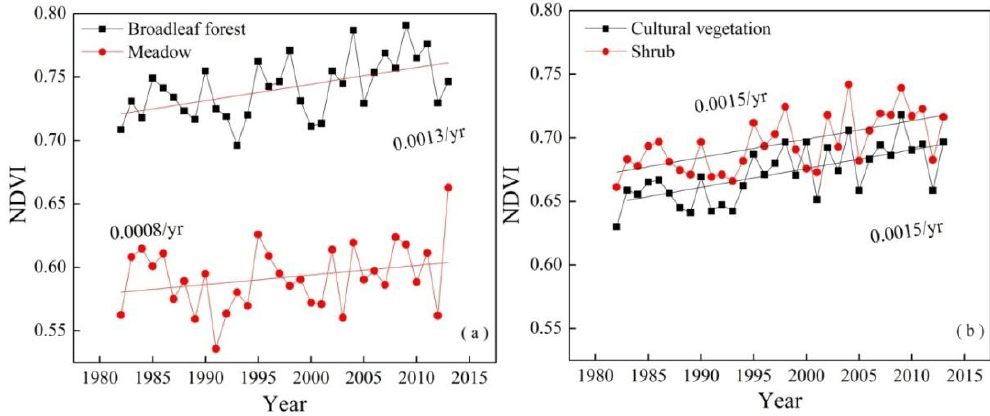
Figure 2. Interannual variations in growing-season NDVI (Normalized Difference Vegetation Index) ( a ) and NDVI anomaly ( b ) during 1982–2013in the entire region, using the annual average growing-season NDVI; ( c ) shows the Mann-Kendall results for trend analysis (α = 0.05, Z1 = −1.96, Z2 = 1.96) . The numbers labeled in the figure are the change rate. The NDVI anomaly is based on the average NDVI of the 32 years.